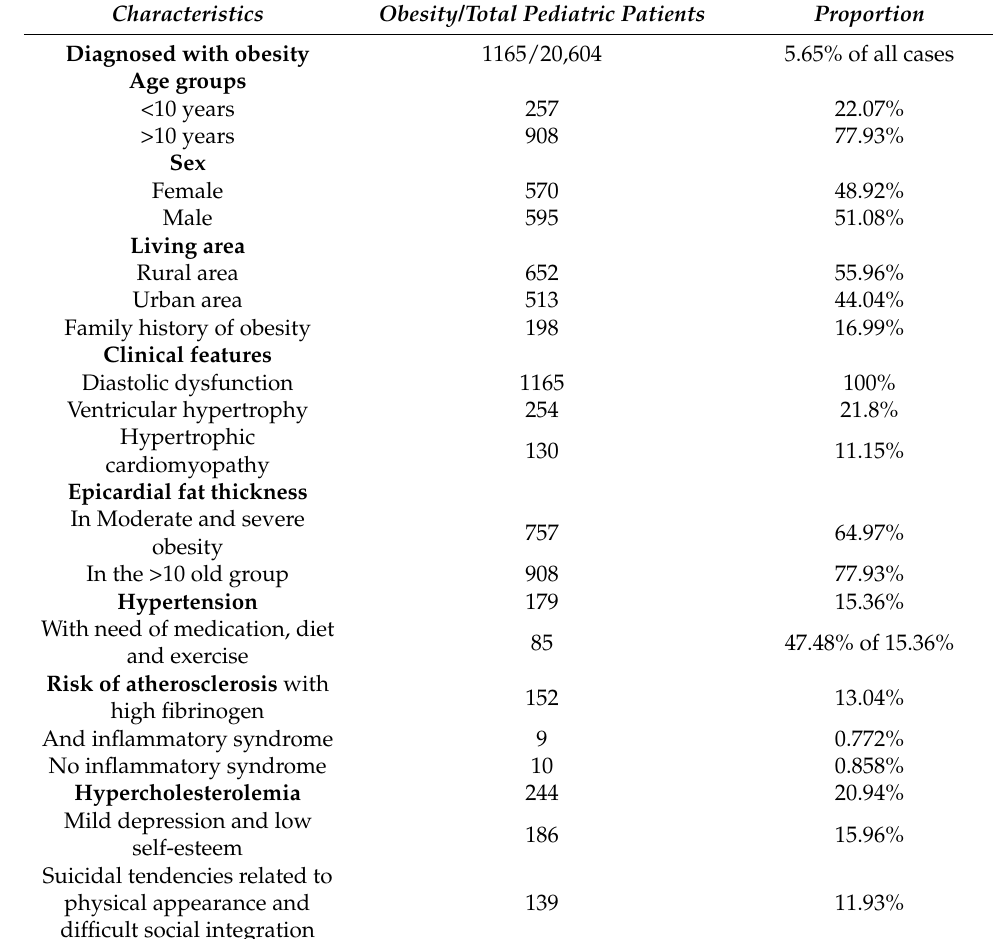
Table 1. Results of our study